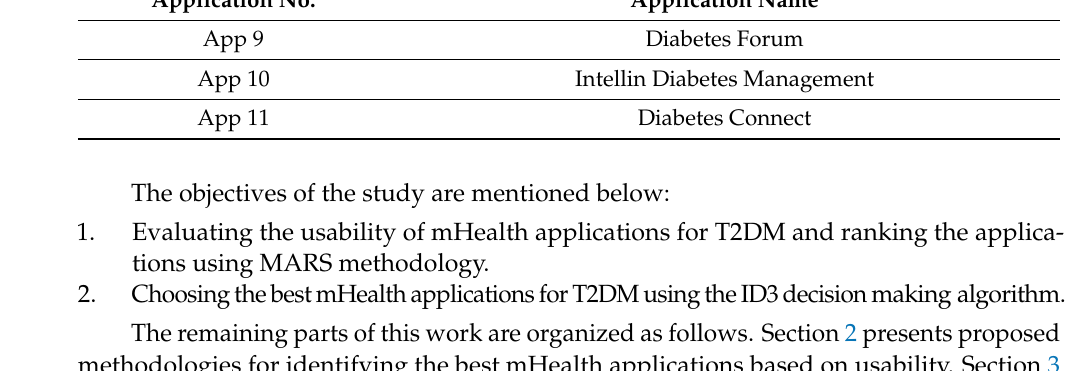
Table 1. Cont . Application